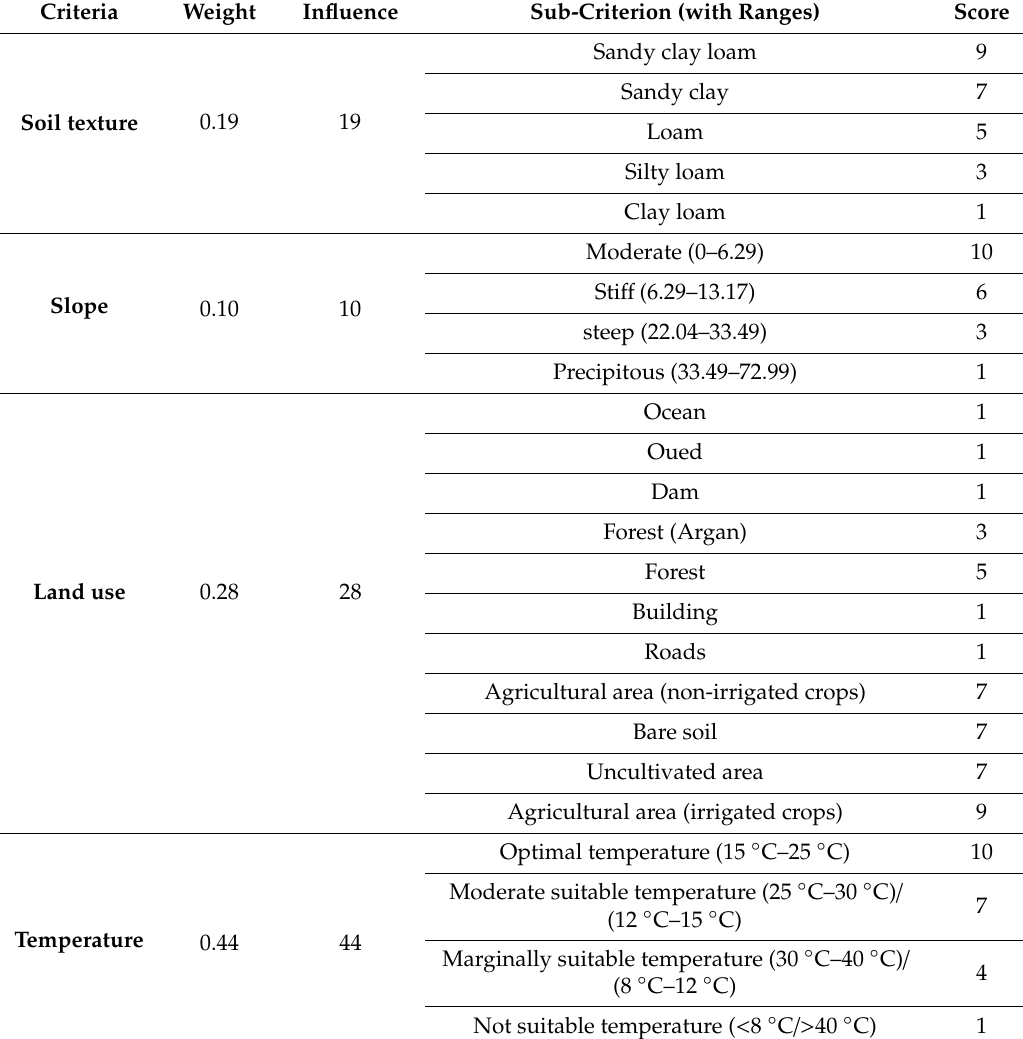
Table 5. Weights of the parameters and scores of the